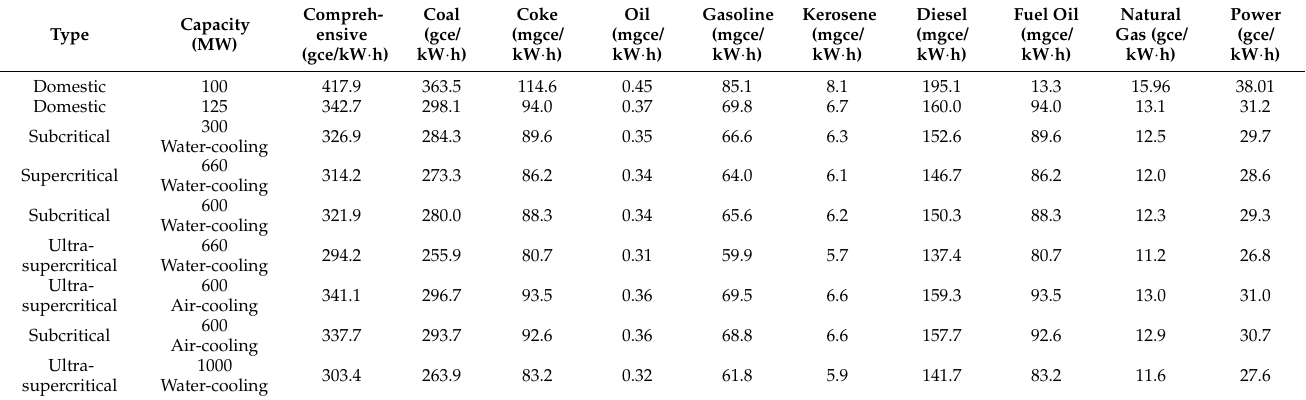
Table 3. Energy consumption of power generation under different capacities of typical units.